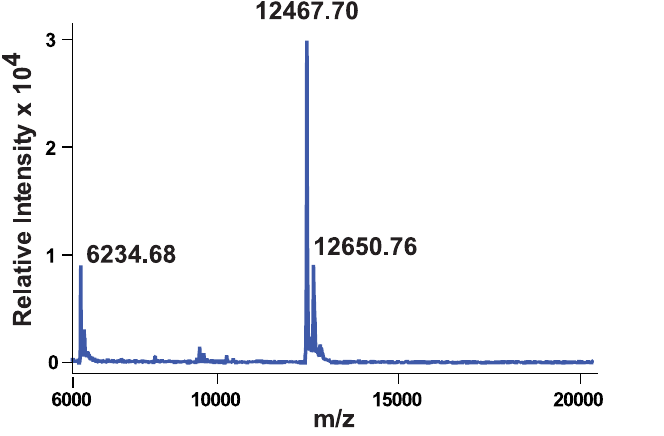
Fig 8. MALDI-TOF spectrum of PelB-Vpu revealsthat the purified protein retains the PelB peptide. The major peak corresponding to the MH + form of the protein was detected at